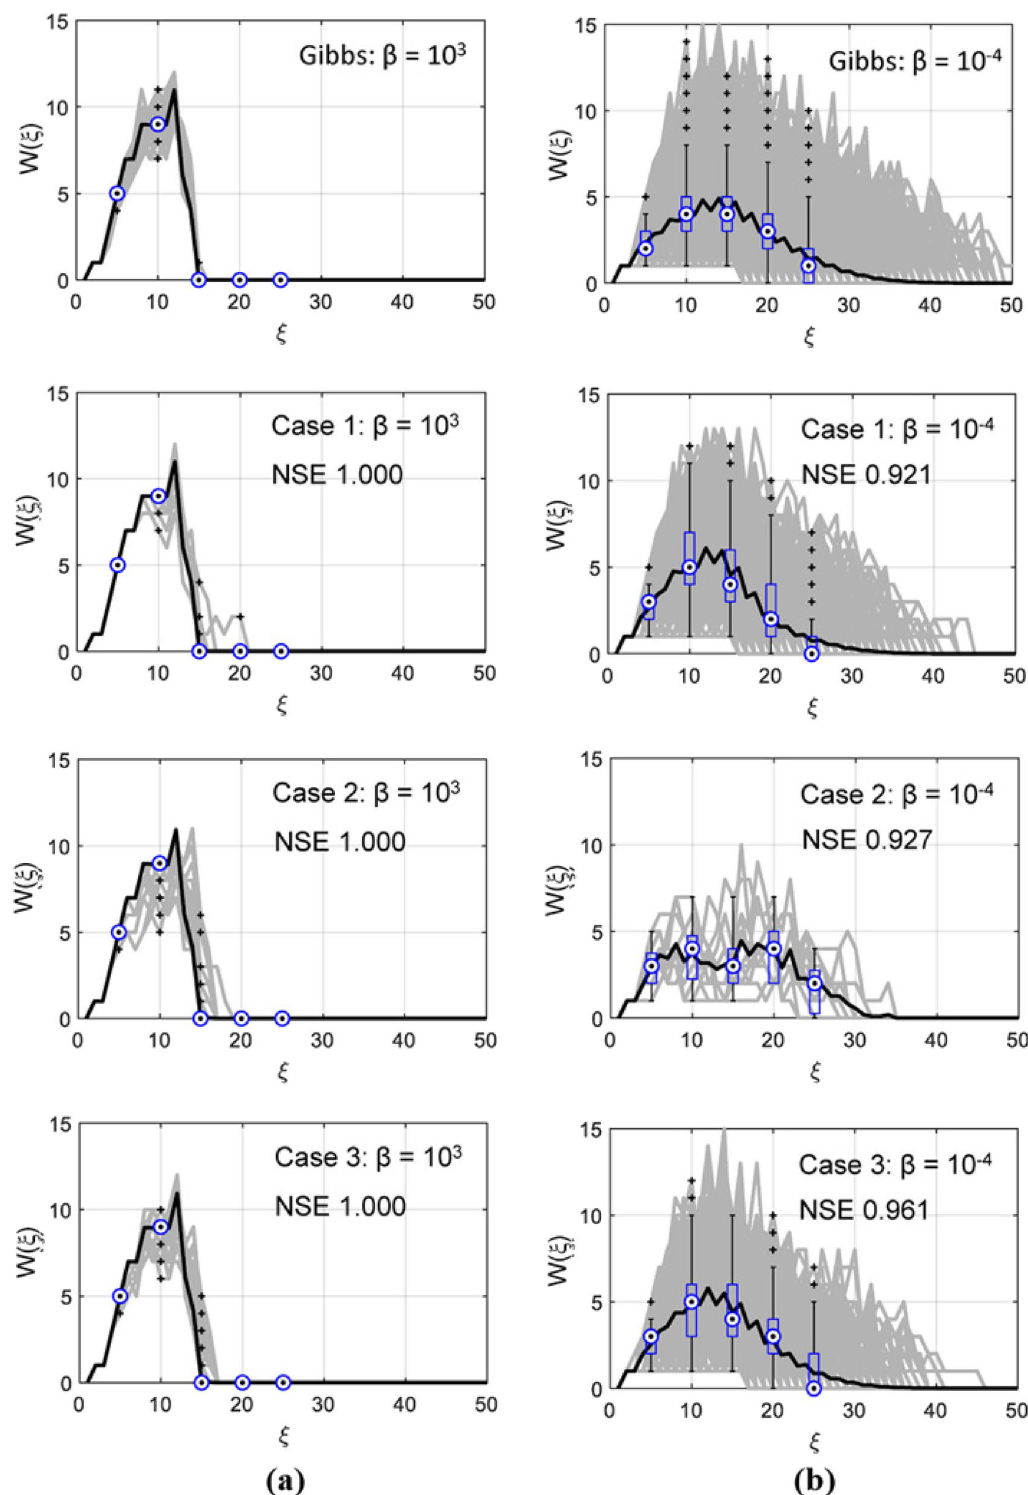
Figure 8. Comparison of width functions of the generated 1000 fully connected networks from ( a ) Gibbs’ model with β = 10 3 (Subcase 1); ( b ) Gibbs’ model with β = 10 − 4 (Subcase 2). The width function for Case 2-2 (Case 2: β = 10 − 4 ) was obtained from only 20 generated networks because Case 2-2 hardly generated the fully connected